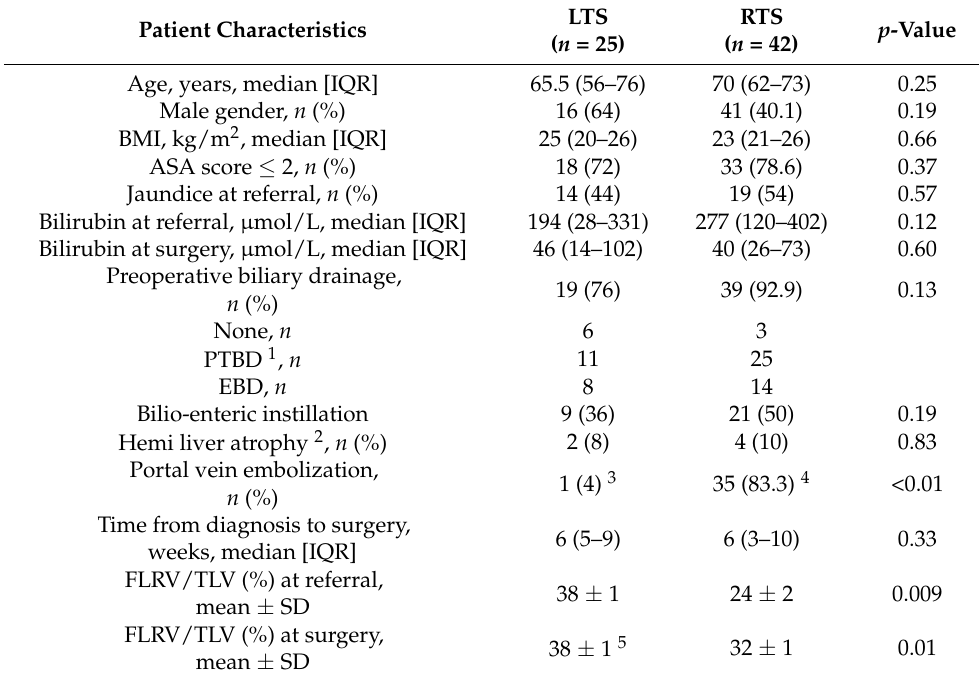
Table 1. Preoperative characteristics and management of patients undergoing RTS or